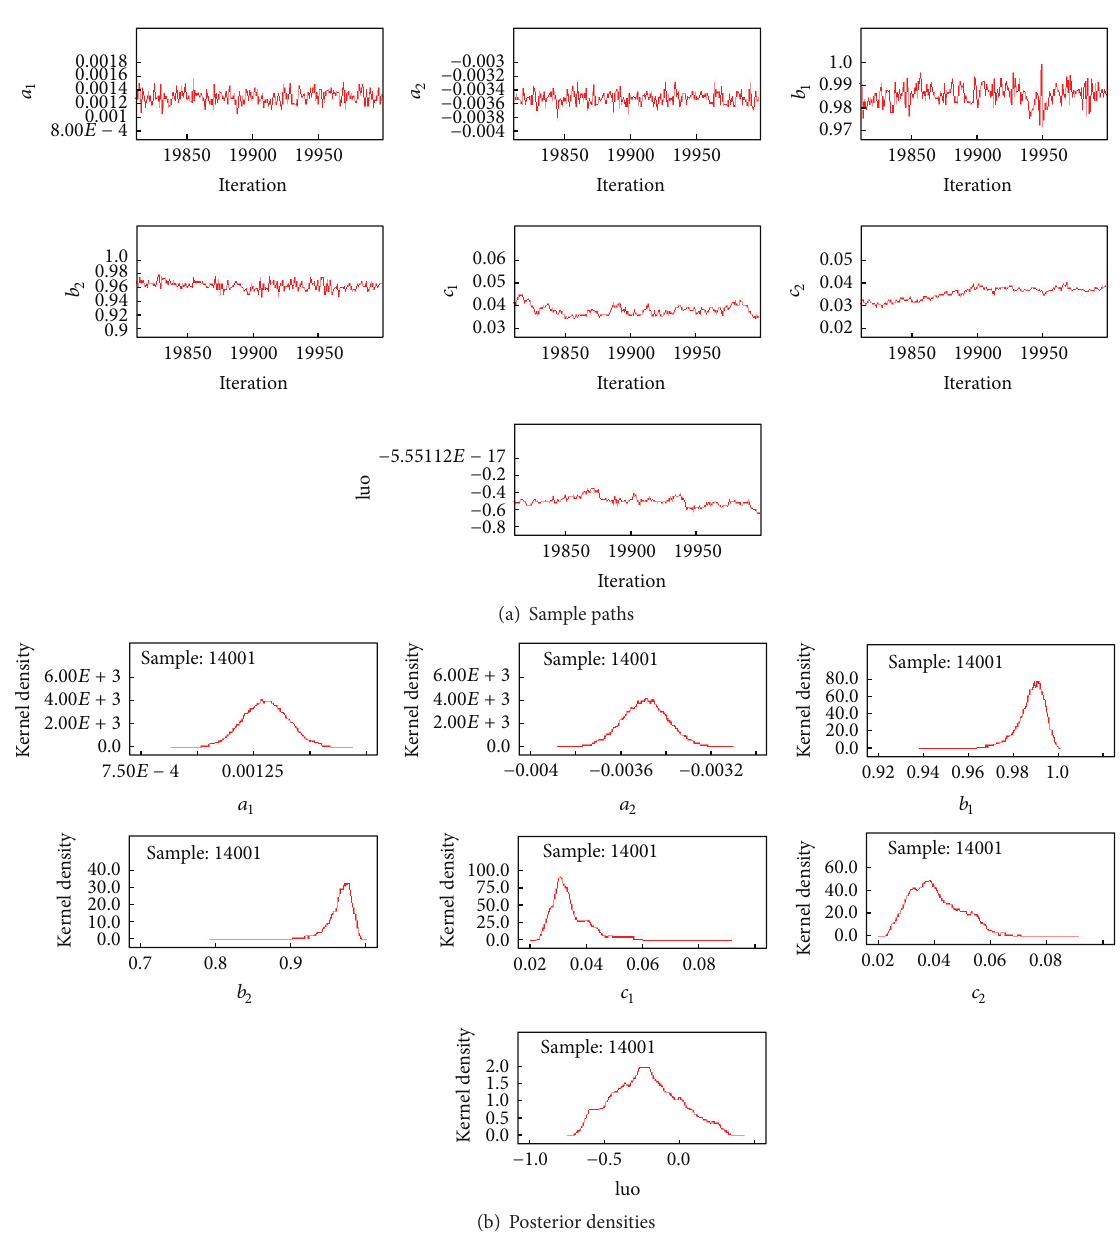
Figure 3: Path and density estimates of the leverage market microstructure model for simulated data (where 𝑎 1 = 𝛼 1 , 𝑎 2 = 𝛼 2 , 𝑏 1 = 1 + 𝛽 1 , = 1 + 𝛽 𝑐 = 𝛾 𝑐 = 𝛾 = 𝜌 ). 𝑏 2 2 , 1 1 , 2 2 , and luo